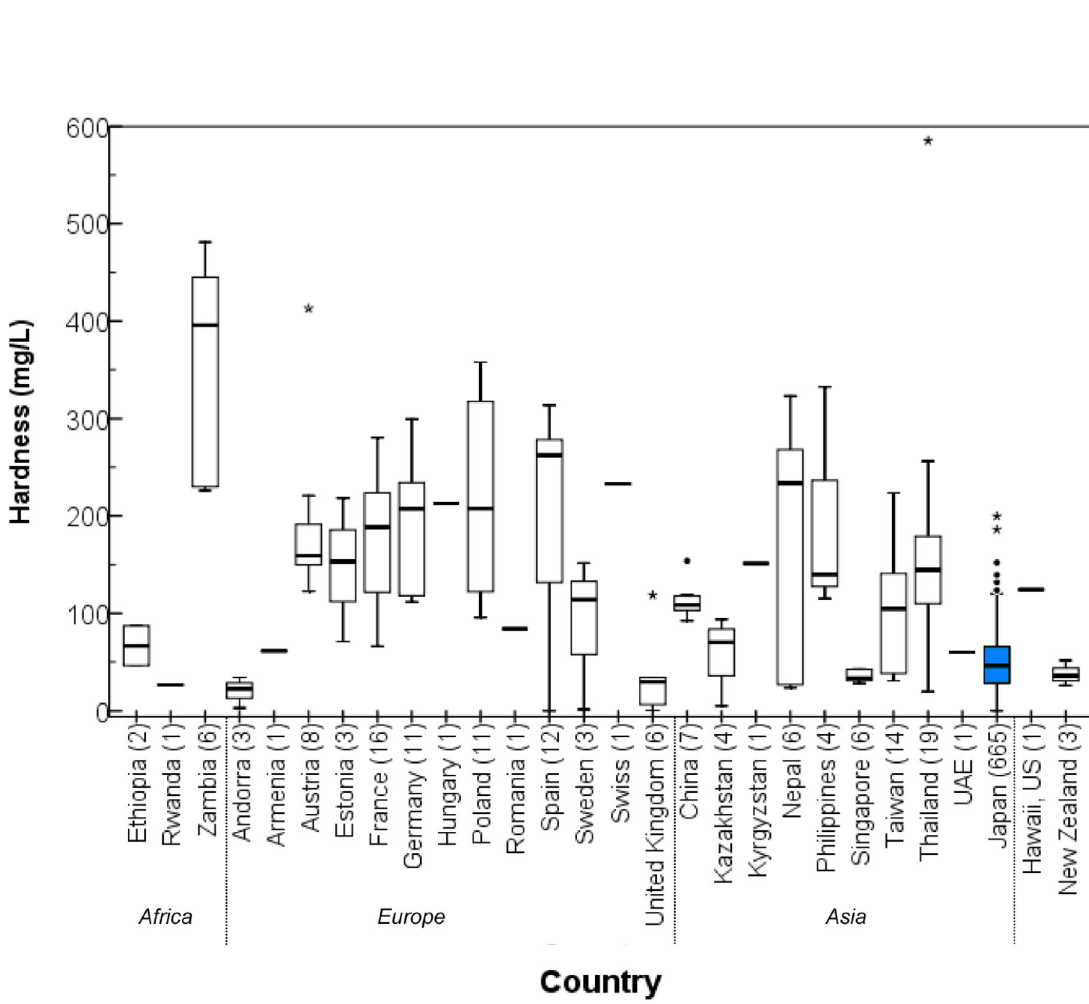
Figure 2. Boxplot showing the distribution of tap water hardness by country. The box shows the interquartile range, with a thick line at the median. The whiskers represent the non-outlying extraquartile range. Outliers are shown as circles (near outliers) or asterisks (far outliers). The number of samples for each country is indicated in